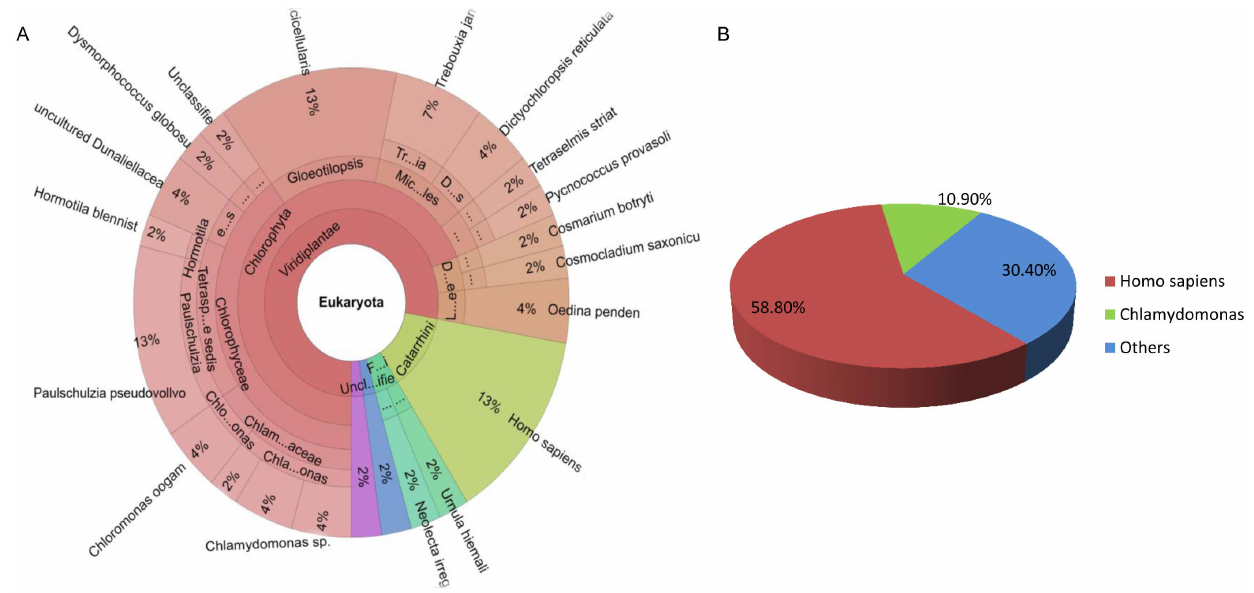
Figure 4. Possible source species identified from simulated metagenomic data by rDNA-reads based method of QC-Chain. (A) 18S reads distribution identified by rDNA-reads based method. (B) Quantitative distribution of the reads identified by random-reads based method.